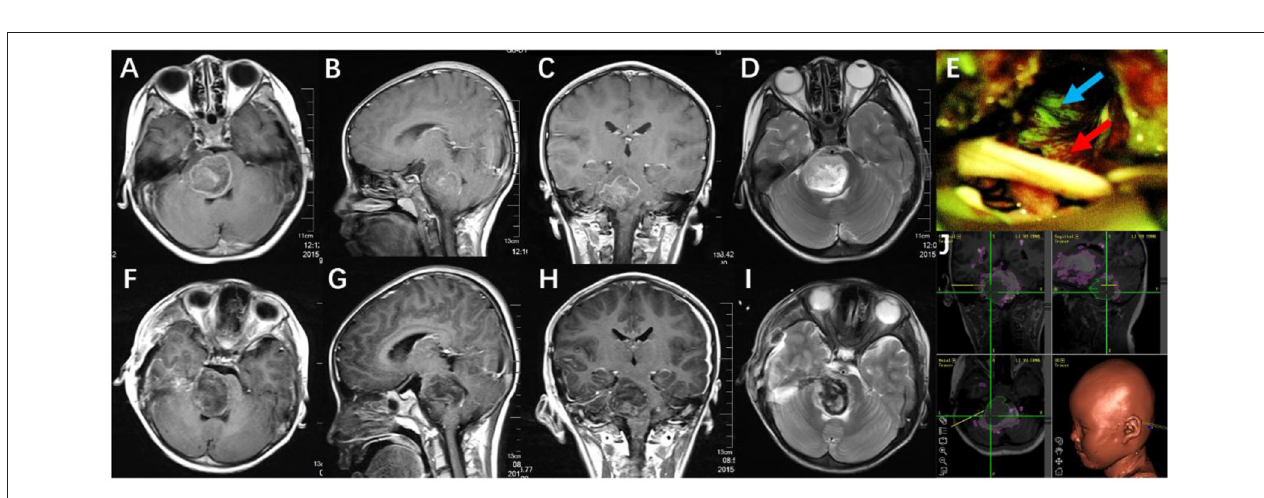
FIGURE 2 | (A–D) Preoperative MRI scan (axial, coronal, sagittal T1-weighted with gadolinium, and T2-weighted) showed a pediatric anaplastic astrocytoma in the right pons. (F–I) Postoperative MRI showed subtotal tumor resection. (E) Tumor was visualized under the YELLOW 560nm filter (blue arrow showed tumor, red arrow showed brain tissue). (J) The surgical plan was made with the assistance of neuronavigation, revealing the relationship between the tumor, white matter tracts, and brainstem